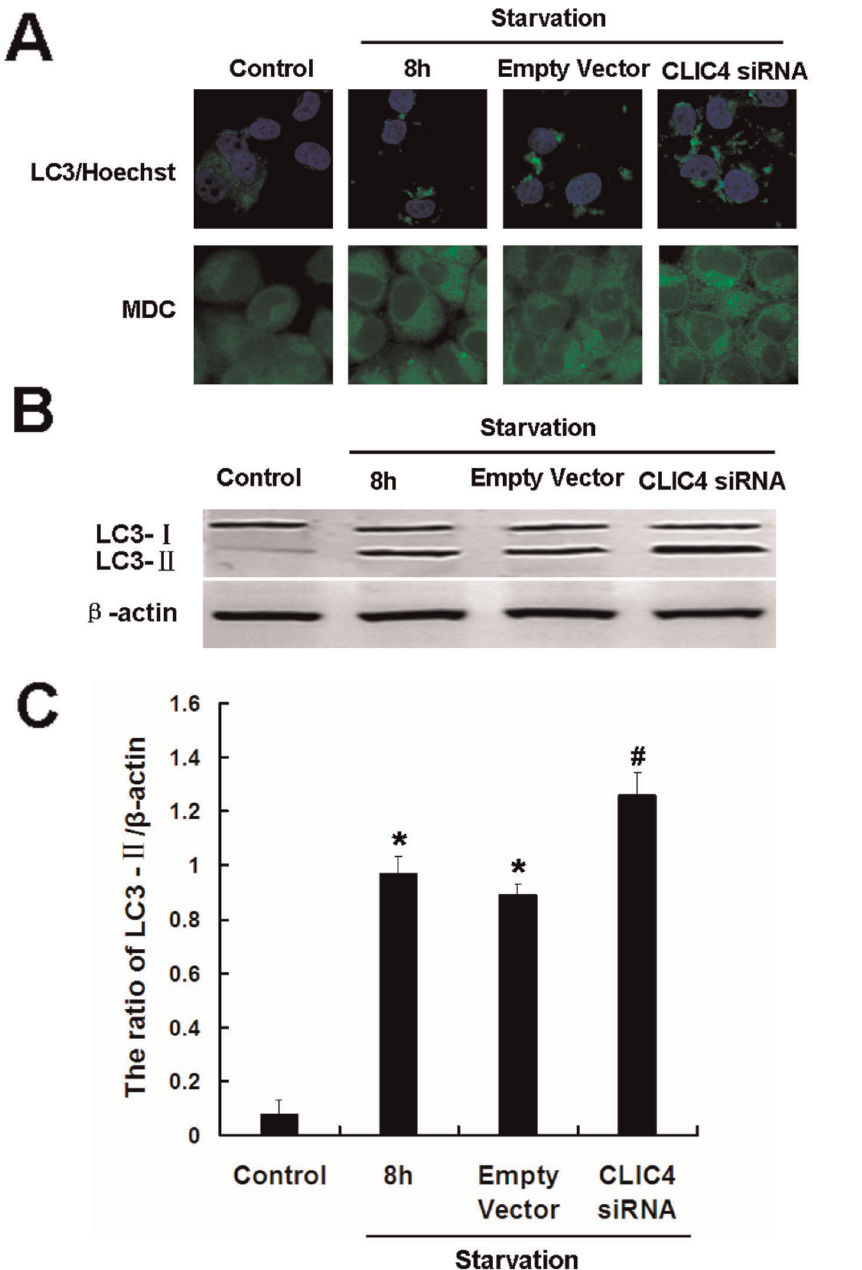
Figure 5. Inhibition of CLIC4 by siRNA enhanced autophagy under starvation conditions in U251 cells. U251 cells were transfected with a plasmid encoding empty vector or CLIC4 siRNA vector for 24 h. (A) LC3 immunostaining (Hoechst 33342 staining for the nucleus, 600 6 ) and MDC staining (900 6 ) were observed by confocal microscopy in U251 cells incubated with EBSS for 8 h. (B) Western blot analysis of LC3 expression in U251 cells incubated with EBSS for 8 h. (C) The ratio of LC3-II/ b -actin. Data were presented as a mean 6 SD of three independent experiments. * P , 0.05 versus control group and # P , 0.05 versus starvation group.